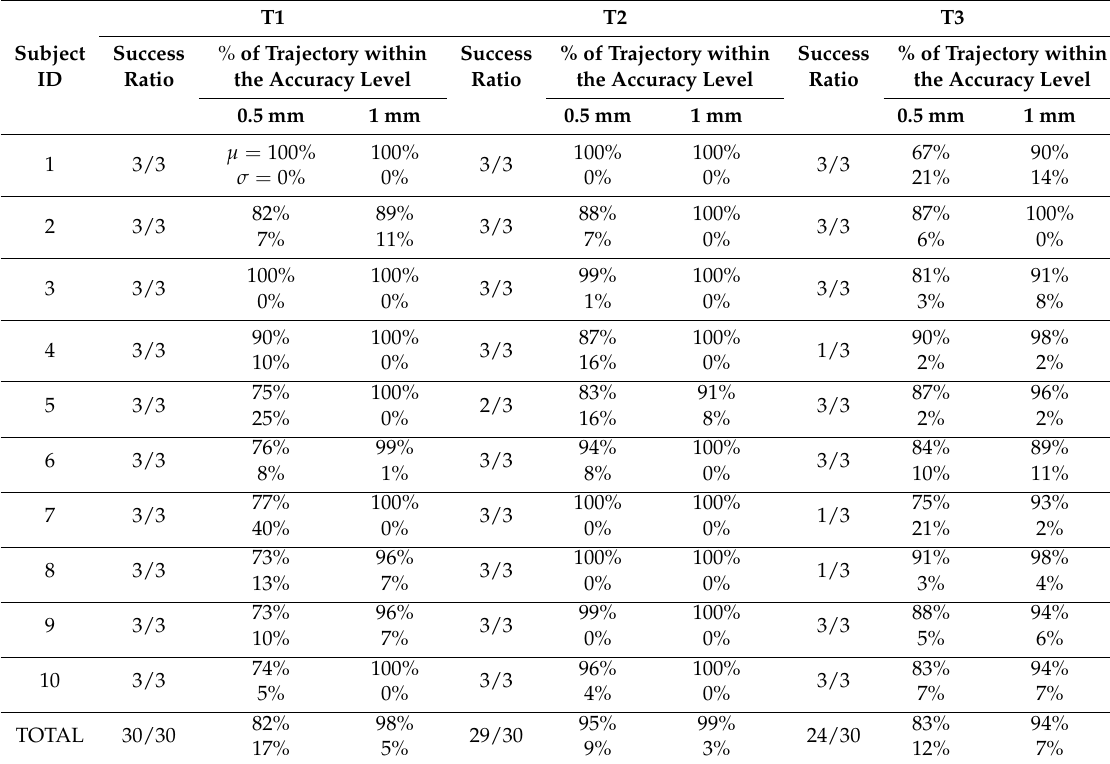
Table 4. Success ratio, mean percentage ( µ ), and standard deviation ( σ ) percentage of traced trajectories within the 0.5 and 1 mm accuracy level. T1 T2 T3